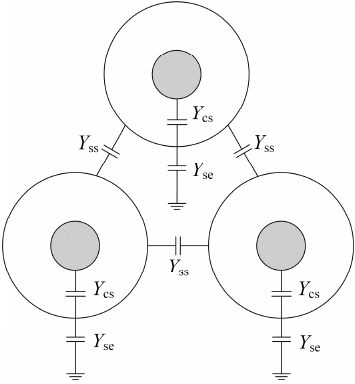
Figure 3. Three-phase cable characteristic admittance model.